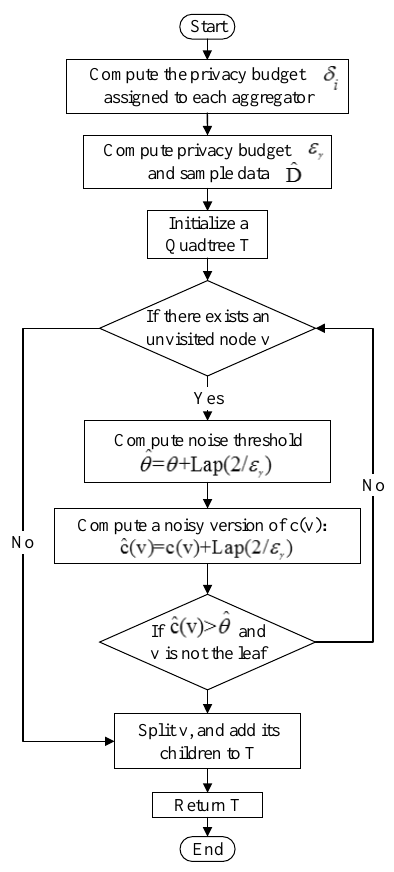
Figure 2. EVs Location Privacy Protection Algorithm with Differential Privacy.